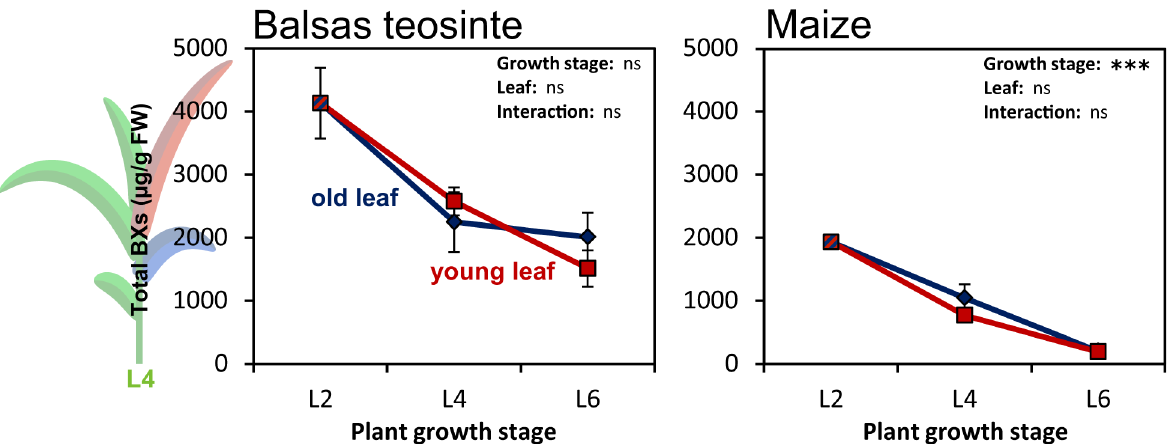
Fig 1. Pairwise comparison of constitutive BX levels in Balsas teosinte and maize. Total 1,4-benzoxazin-3-one (BX) concentrations were calculated as the sum of seven individual BX glucosides in one population of Balsas teosinte (left) and one maize inbred line (B73, right) at three different growth stages and are given as μ g / g fresh weight (FW) (mean ± SE; N = 5 – 6). BX levels were monitored in old (blue) and young (red) leaves as indicated in the drawing to the left-hand side for growth stage L4. Note that at L2 old and young leaf were the same. Significant effects of growth stage and leaf identity on total BXs are indicated by asterisks: * P < 0.05; ** P < 0.01; *** P < 0.001; ns: not significant; two-way ANOVA without growth stage L2. Chemical data for B73 has been published before